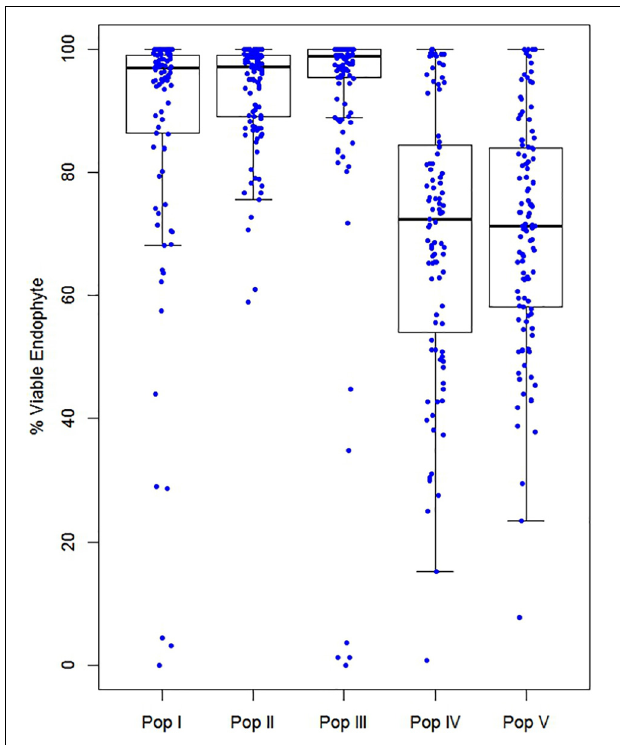
FIGURE 2 | Box plots of AR37 transmission into seedlings in Populations I–V. Seeds were harvested from parental lines grown at the Grasslands Research Centre (GRLDS) in 2013, and emergent seedlings were tested for the presence of viable endophyte by tissue-print